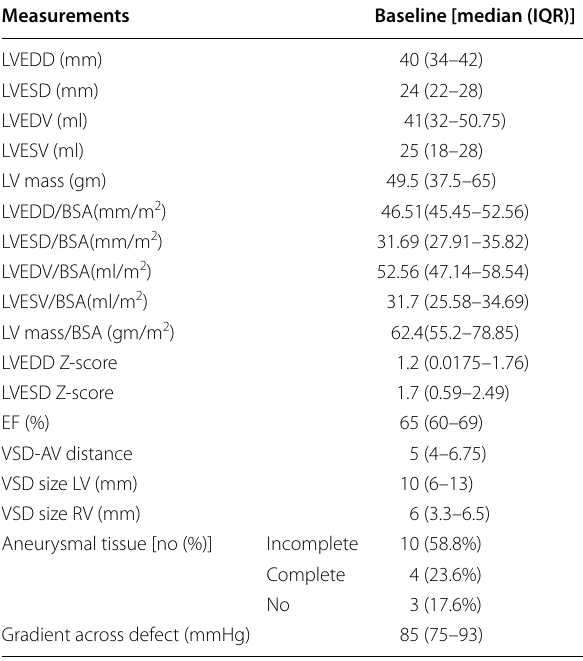
Table 3 Baseline echocardiographic characteristics Table 4 LV echocardiographic parameters before and